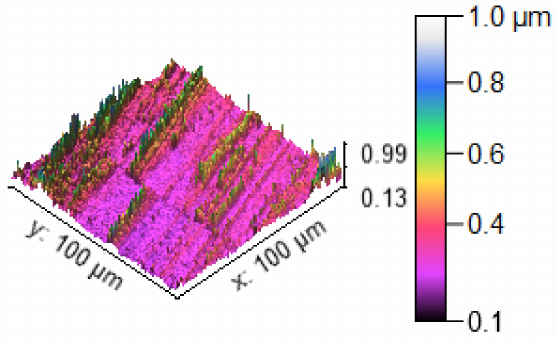
Figure 15. Three dimensional (3D) profilometric image